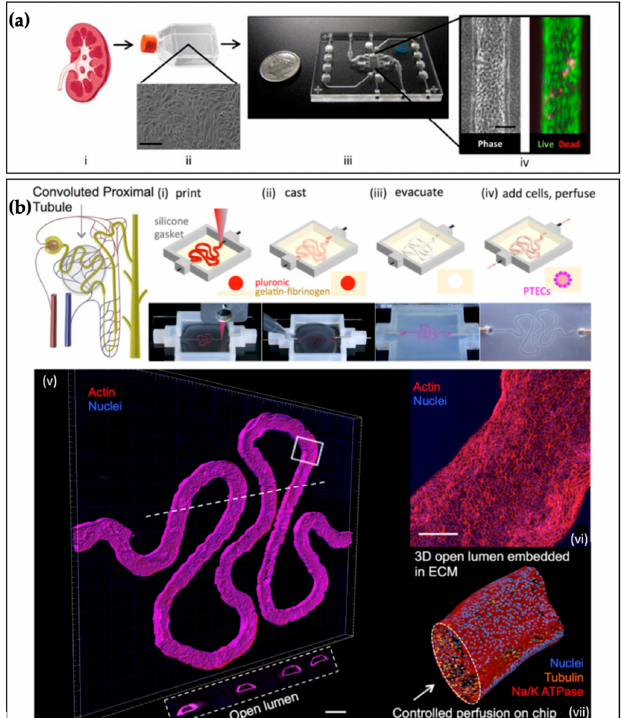
Figure 5. ( a ) Schematics of isolated human kidney tissue ( i – ii ) seeded into Nortis Inc.’s single- channel 3D MPS platform ( iii ) with phase contrast and live/dead images of primary RPTEpCs at day 28 ( iv ). Reproduced with permission from Elsevier [136]. ( b ) Convoluted proximal tubule schematic and images of Homan et al.’s 3D bioprinting fabrication steps ( i – iv ) and confocal